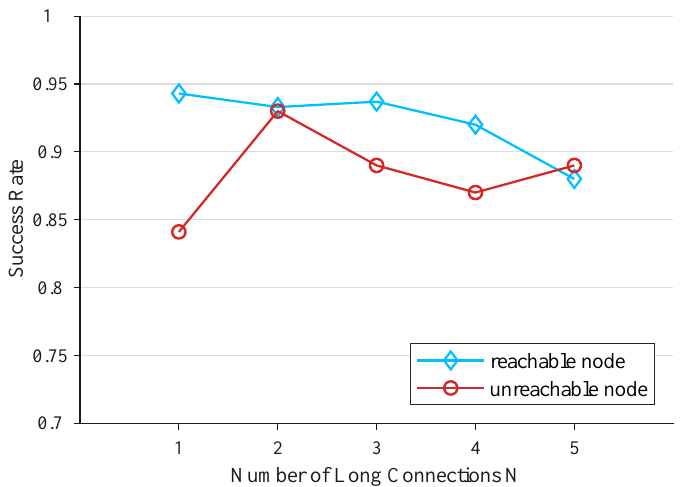
Figure 19. Lookup success rate of reachable and unreachable nodes with different number of long connections